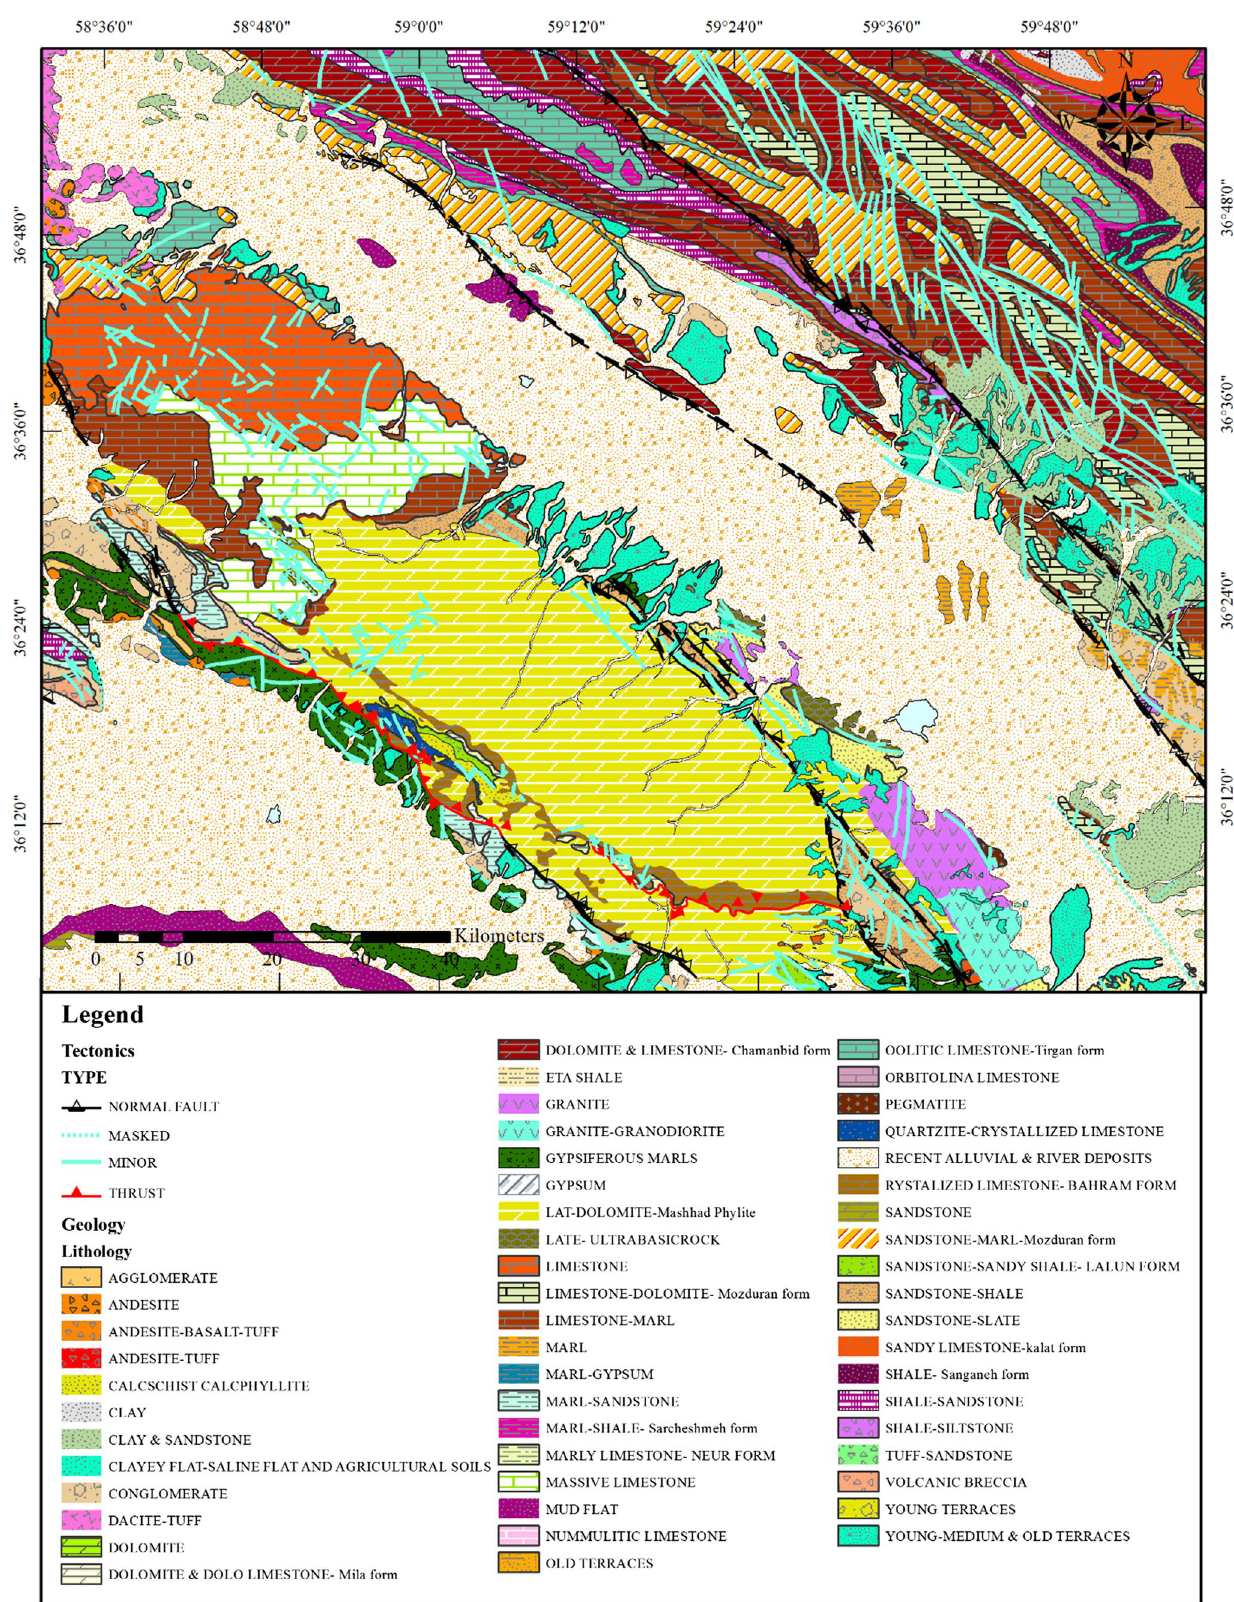
Fig. 2 Geological map of Mashhad: